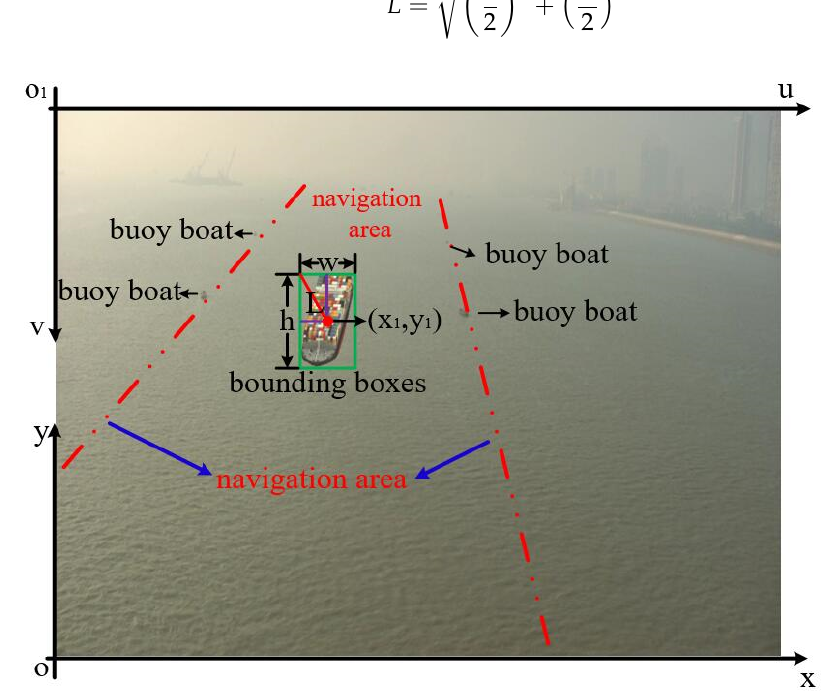
Figure 4. Modeling of simulation ship in background scene.